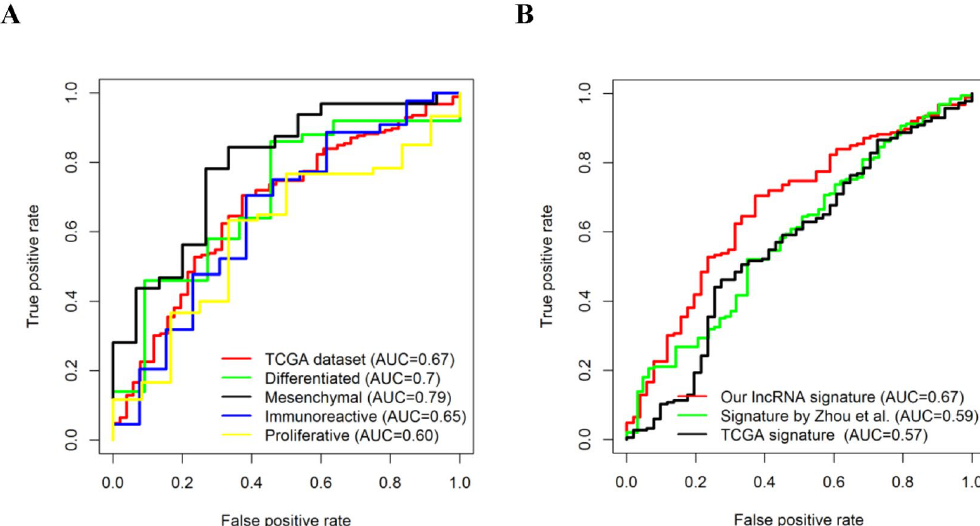
Figure 2. ROC curves for the eight-lncRNA signature in predicting chemoresponses. ROC curves represents the accuracy of the lncRNA signature in the training dataset and different subtypes in predicting chemoresponses ( A ), and the accuracy of our defined lncRNA signature, the lncRNA signature developed by Zhou et al. , and the TCGA mRNA prognostic signature ( B ). True positive rate represents sensitivity, whereas false positive rate is one minus the specificity.